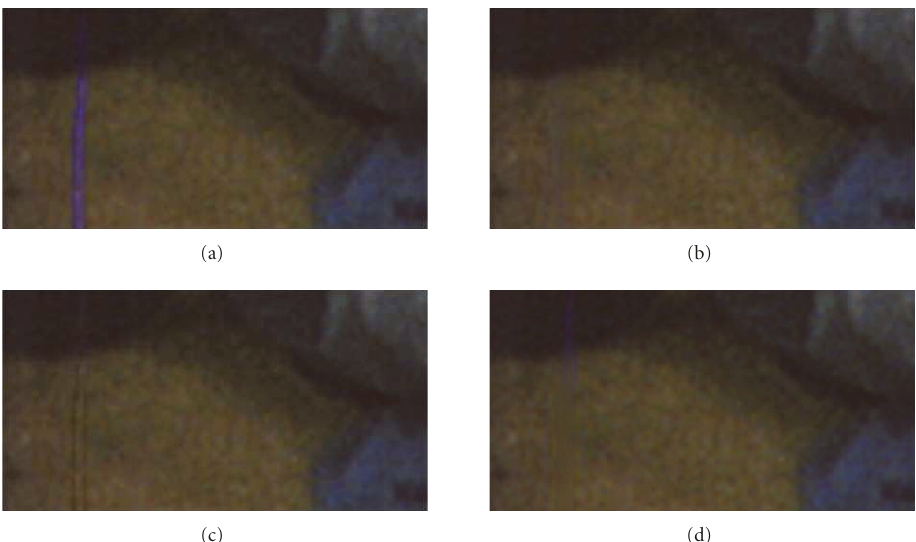
Figure 9: Zoom of the blue scratch in Figure 2(a) restored using the proposed algorithm (b), the method in [12] (c), and the method in [7]